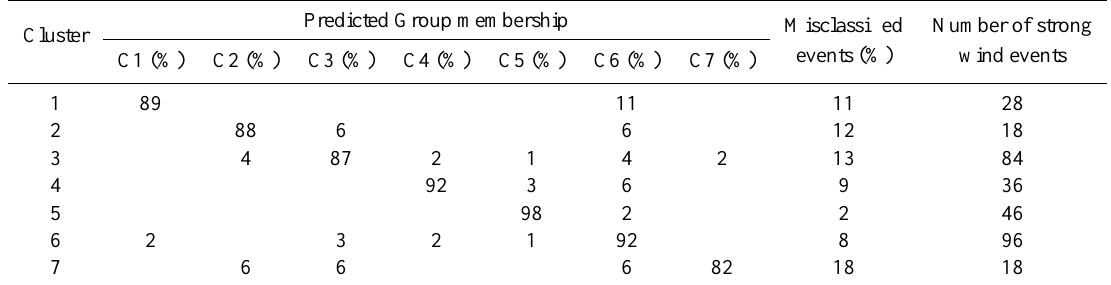
Table 3. Predicted percentage of the clusters obtained from the discriminant analysis. Diagonal values correspond to correctly classified events, and the remaining values across a row the misclassified